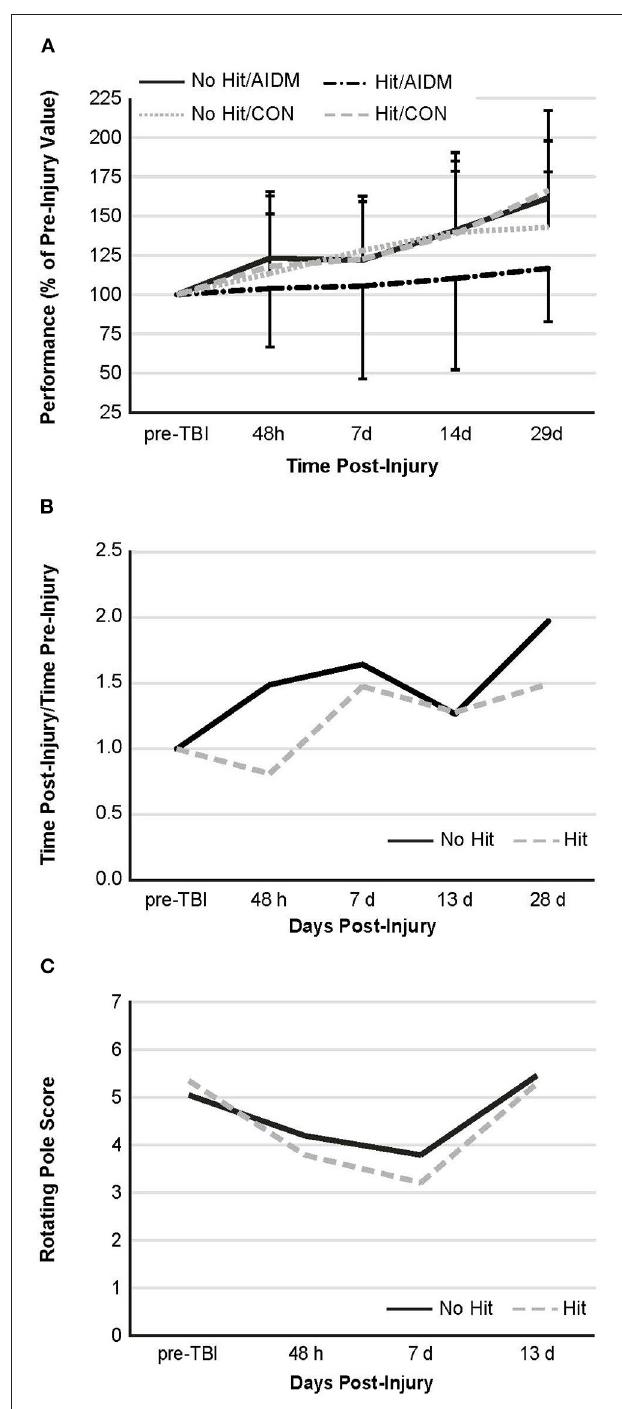
FIGURE 5 | Behavioral measures. (A) Rotarod performance—mean duration (latency to fall time) on the Rotarod at four time points post-injury, as a percentage of the time sustained on the apparatus pre-injury. There is no significant difference between groups at any of the time points post-injury. Values are mean ± SDEV, for 11–12 rats/group B and C. Rotating pole performance—mean effort to traverse the pole post-TBI, as compared to that required on the apparatus pre-injury. Rats were divided into TBI-exposed (Hit)